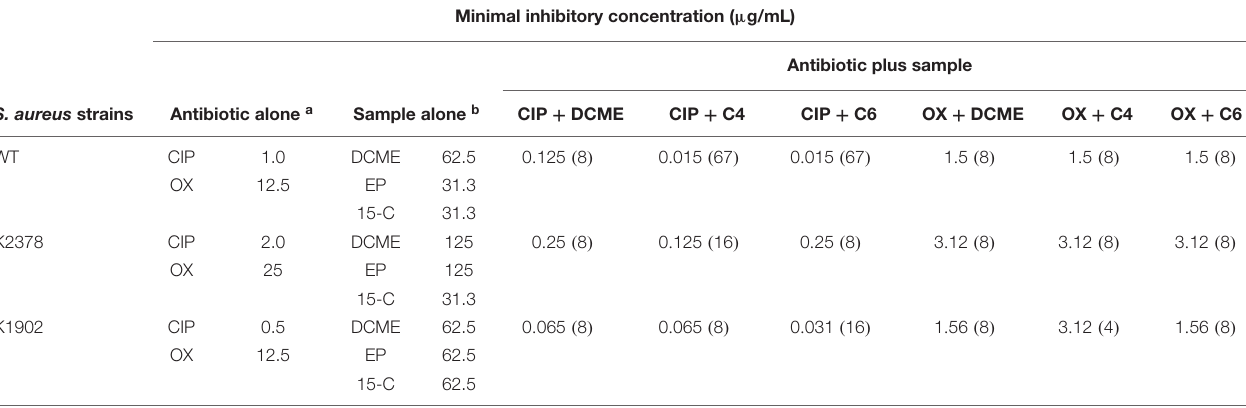
TABLE 3 | Minimal inhibitory concentration of extract and isolated compounds from P. uviferum , and antibiotics and mixtures against S . aureus strains. Minimal inhibitory concentration ( µ g/mL)